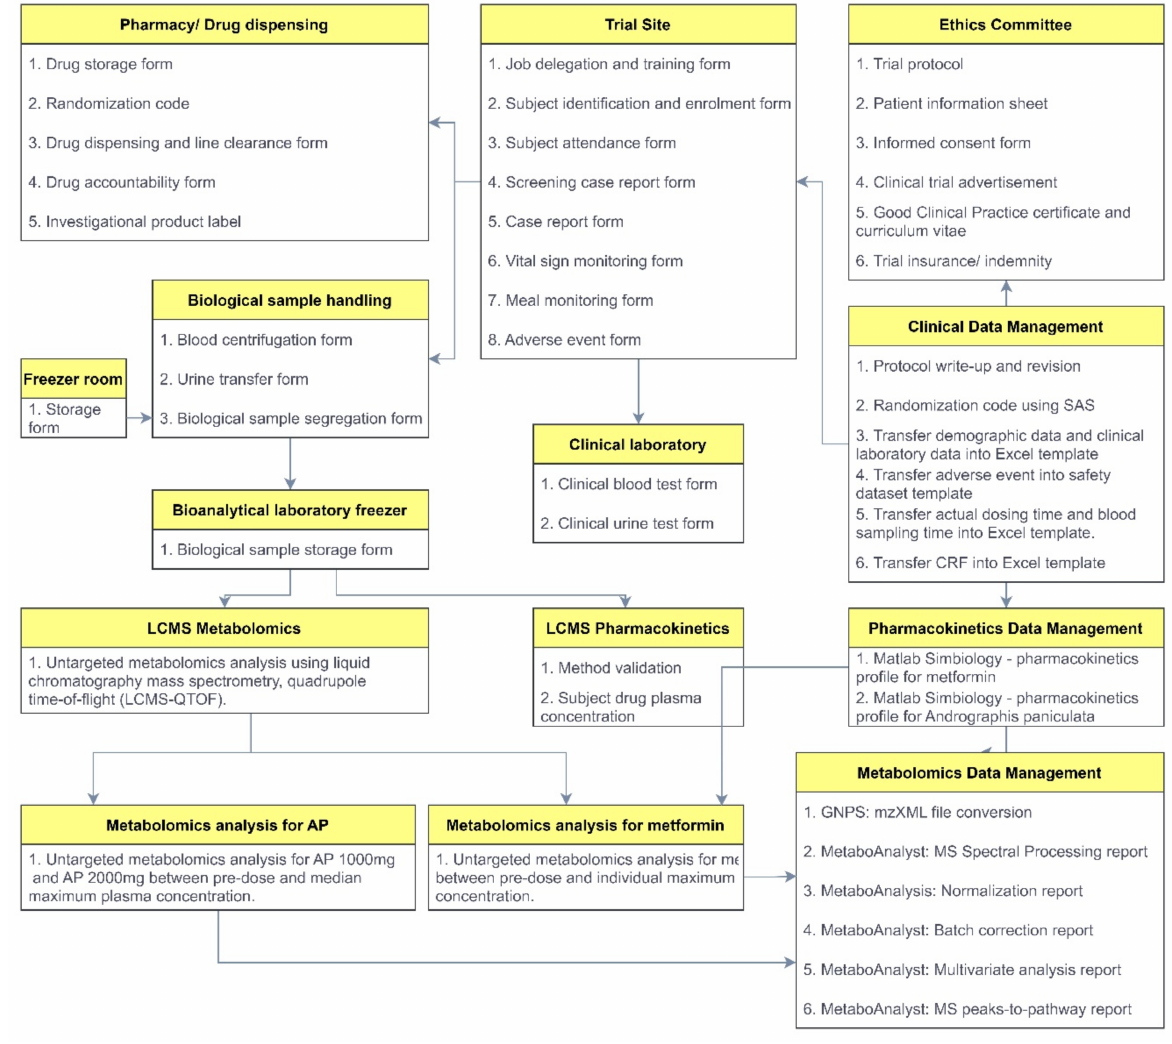
Figure 4. The forms and templates of the data collection, management, and statistical